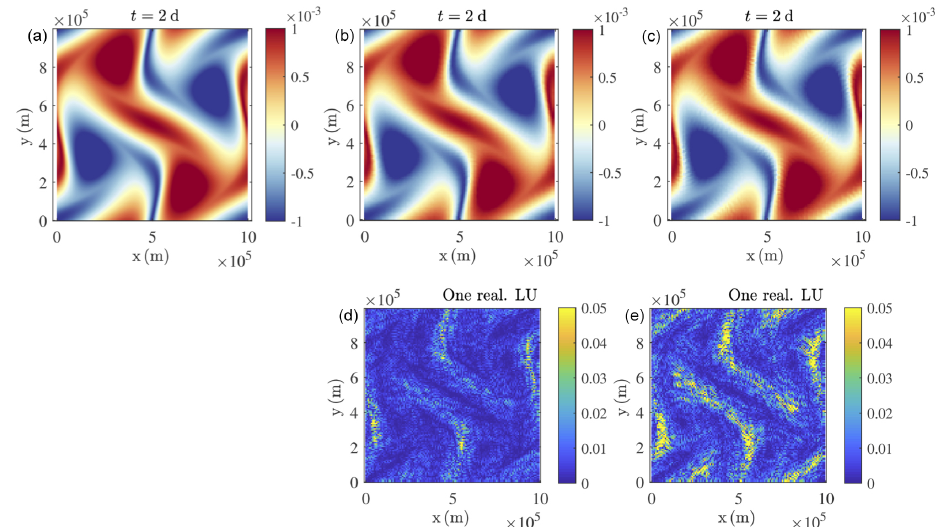
Figure 2. Buoyancy field (ms − 2 ) (a, b, c) and corresponding normalized error (dimensionless) (d, e) after 1d of advection for the 1024 × 1024 reference deterministic simulation (a) , the 128 × 128 LU simulation with the self-similar parameterization (b, d) , and the 128 × 128 LU simulation with the method of Resseguier et al. (2017b) (c, e) .